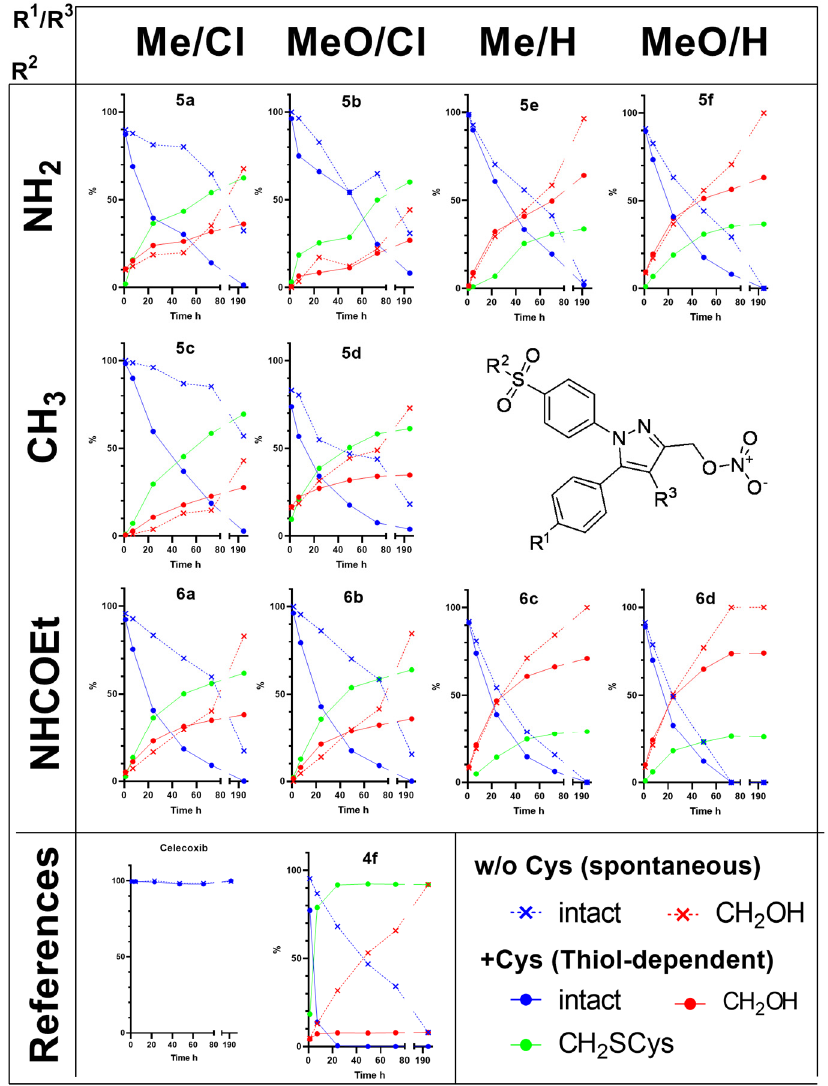
Figure 4. Spontaneous and thiol-dependent conversion of NO-COXIBs followed by HPLC-UV ( λ = 254 nm); Y-axis shows relative fraction of intact compound and the respective conversion products, i.e., the hydroxy derivative (CH 2 OH) and the cysteine adduct (CH 2 Cys) detected in the incubation buffer at the indicated time points in the presence or absence of cysteine.